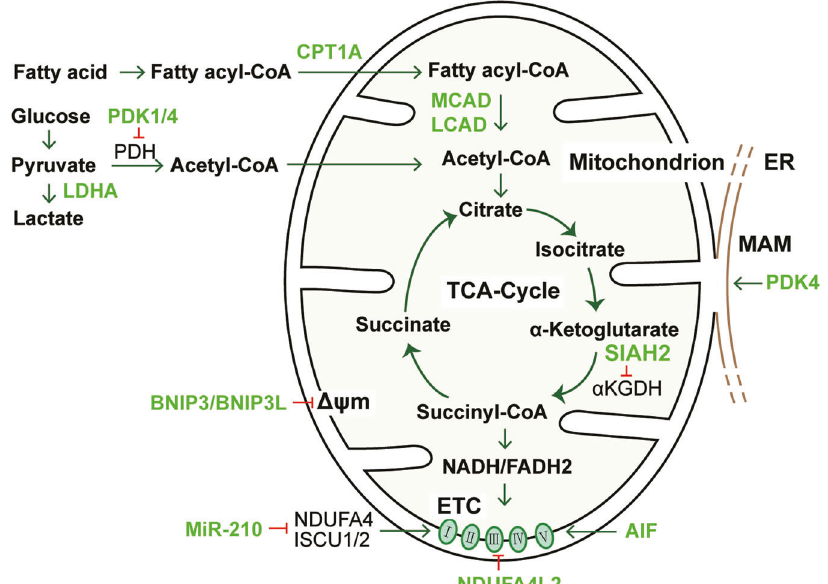
Fig. 2 HIF-mediated regulation of mitochondrial metabolism. For hypoxic adaptation, HIF transcriptionally regulates the expression of a subset of genes to reduce mitochondrial metabolism and oxygen consumption. The expression of these genes in fl uences the core functions of mitochondria by affecting TCA cycle substrate availability, Δψ m, TCA cycle operation and respiratory chain function. The molecules directly regulated by HIF are shown in lime color. ER endoplasmic reticulum. MAM mitochondria-associated ER membrane. ETC electron transport chain. TCA cycle tricarboxylic acid cycle. Δψ m mitochondrial membrane